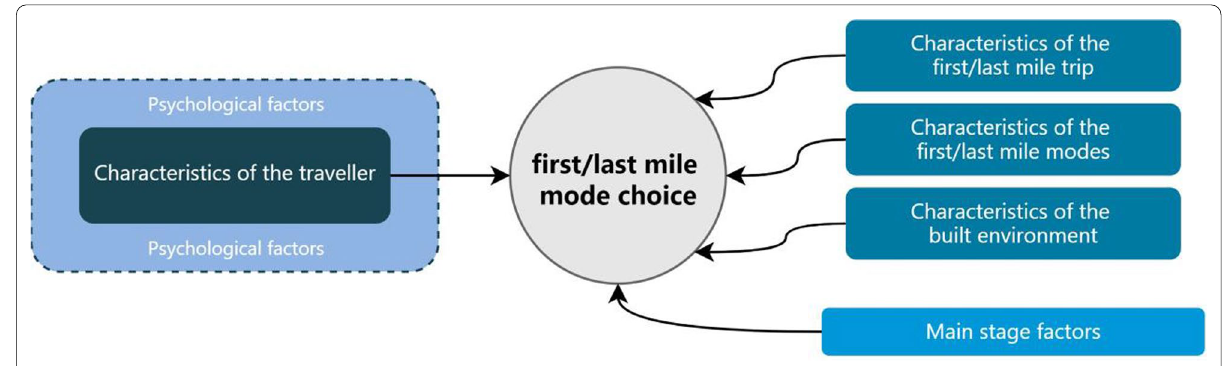
Fig. 2 First/last mile mode choice